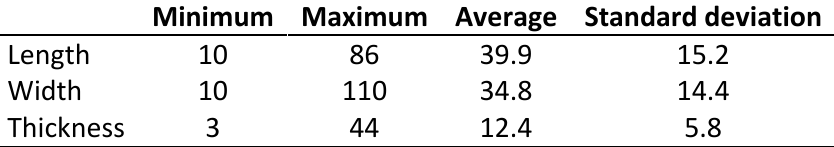
Table 2. Measures in millimetres of central tendency (average) and standard deviation for the 143 flakes and